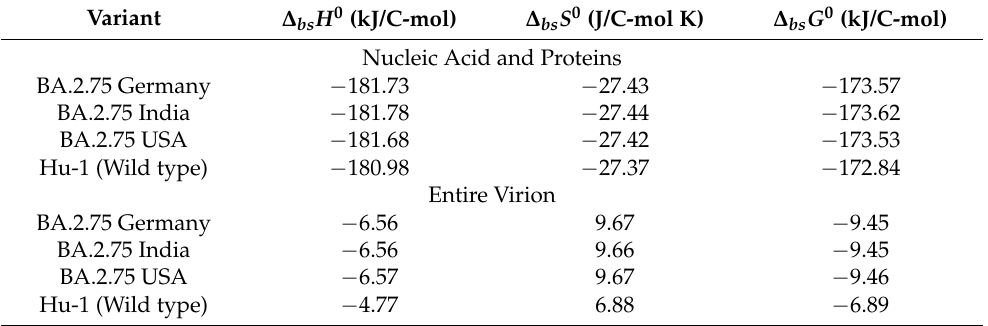
Table 8. Standard thermodynamic properties of the biosynthesis of SARS-CoV-2 nucleic acid and proteins and entire virions. Nucleic acids and proteins represent the viral RNA together with thee nucleoprotein, membrane proteins, and spike protein. On the other hand, the entire virion includes nucleic acid, proteins, and envelope lipids. The table gives data on the standard enthalpy of biosynthesis, ∆ bs H 0 , standard entropy of biosynthesis, ∆ bs S 0 , and standard Gibbs energy of biosynthesis, ∆ bs G 0